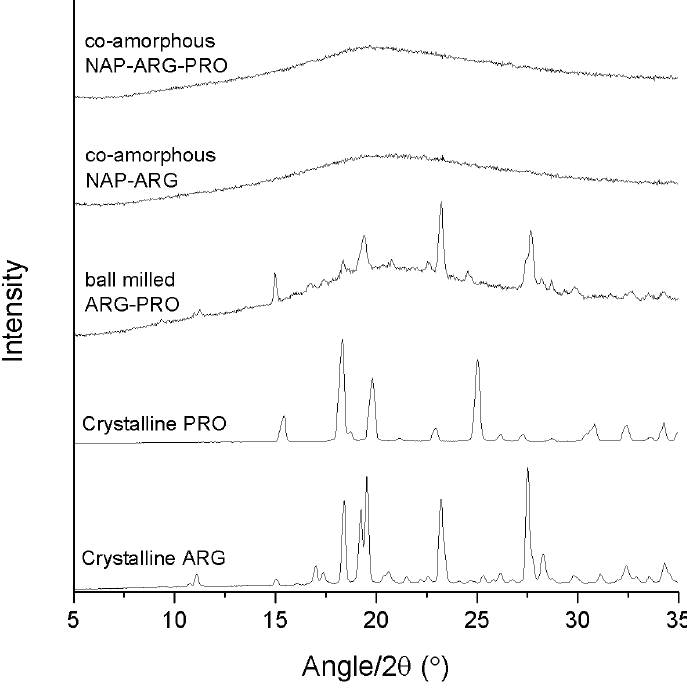
Figure 2. XRPD diffractograms of crystalline ARG, crystalline PRO, ball-milled ARG–PRO, co-amorphous NAP–ARG and co-amorphous